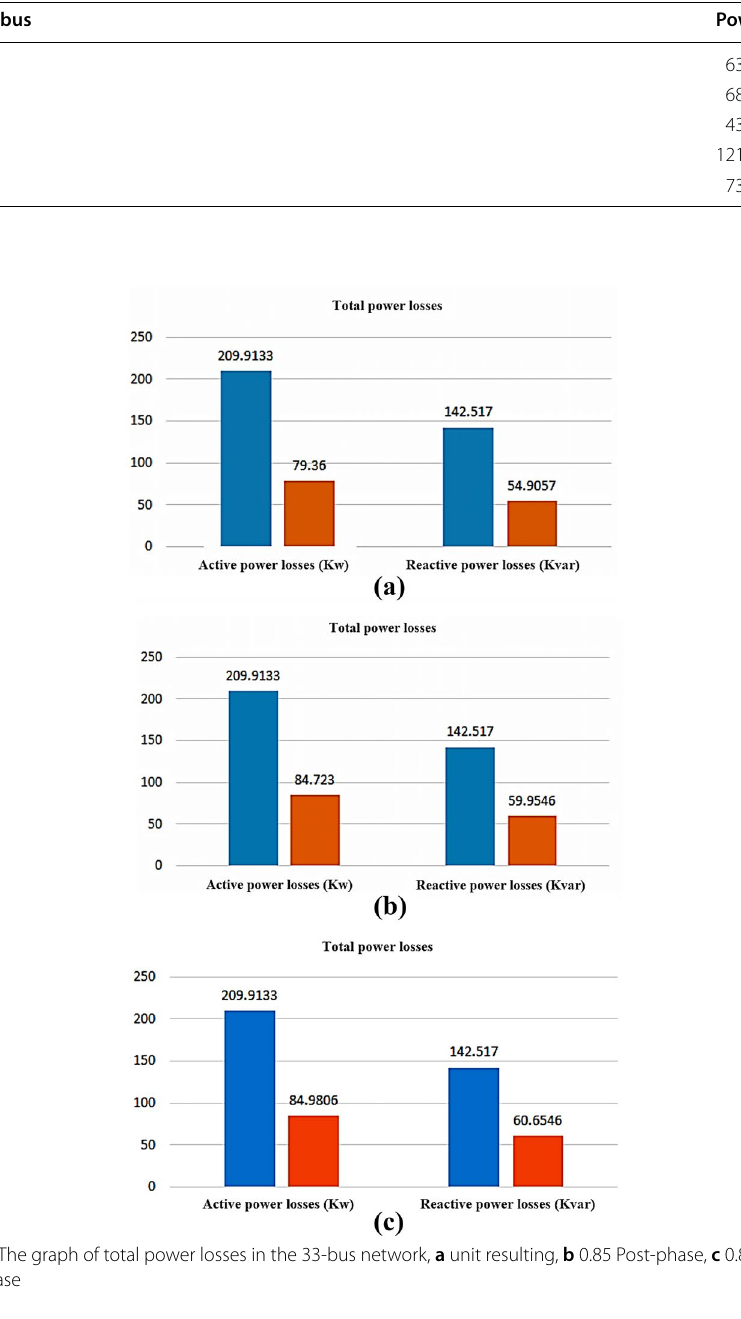
Table 2 Parameters of placement and sizing under the output power factor of 0.85, post-phase in the 33-bus network